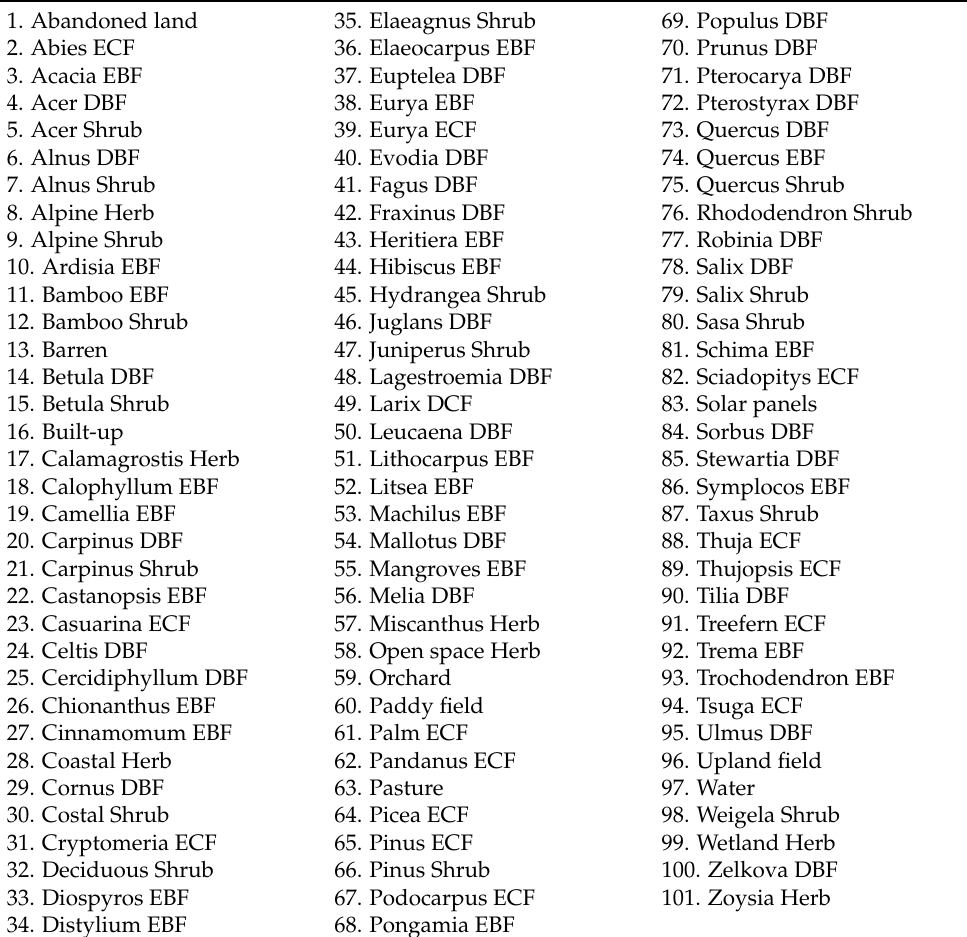
Table 1. List of Dominant Genus-Physiognomy-Ecological (DGPE) communities enumerated coun- trywide including land cover and agricultural